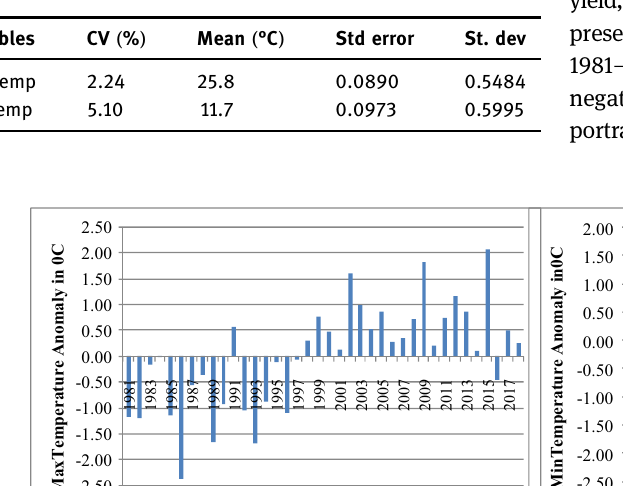
Table 6: Descriptive statistics for maximum and minimum tem - peratures in te ff growing areas